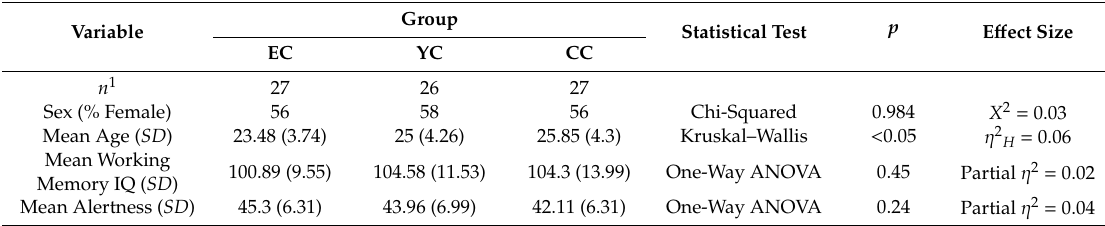
Table 1. A priori group comparisons in study